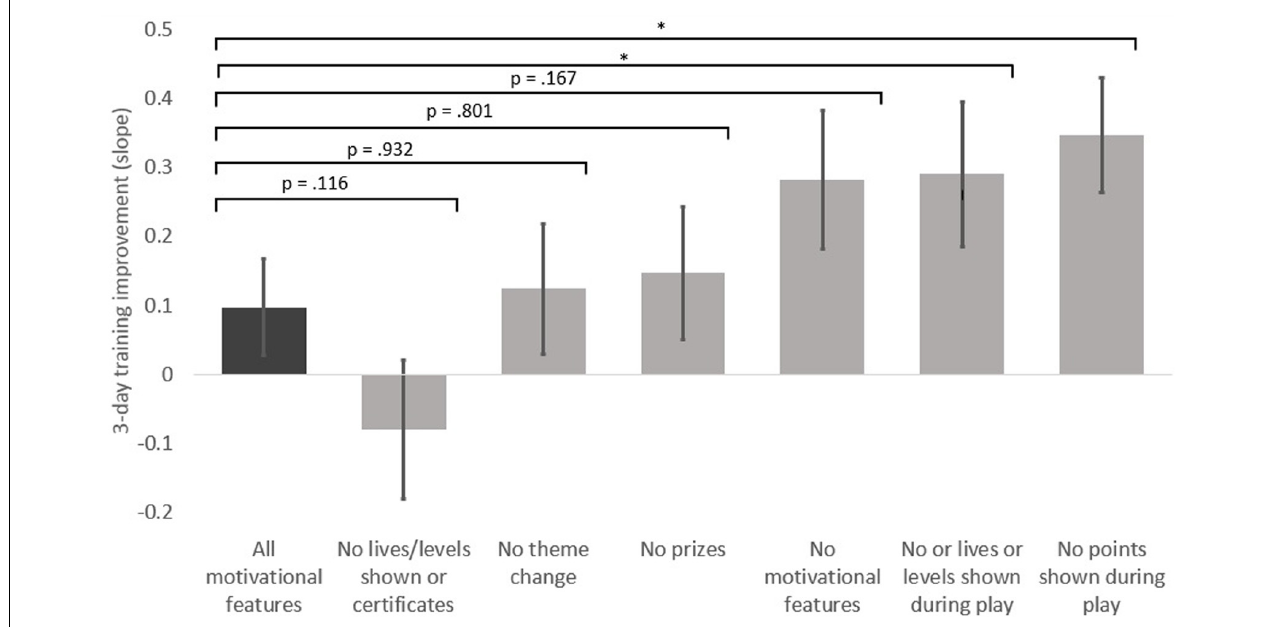
FIGURE 5 |Adjusted means of training slope by game-type controlling for age and baseline n-back level. Means are estimated at age = 10.65 and baseline n-back = 2.49. Error bars represent standard error. * p < 0.05.